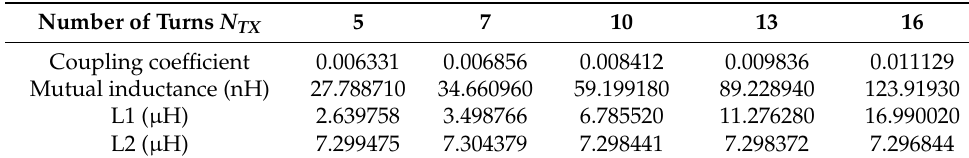
Table 9. Simulation results of circular coil model—number of turns N TX variation.